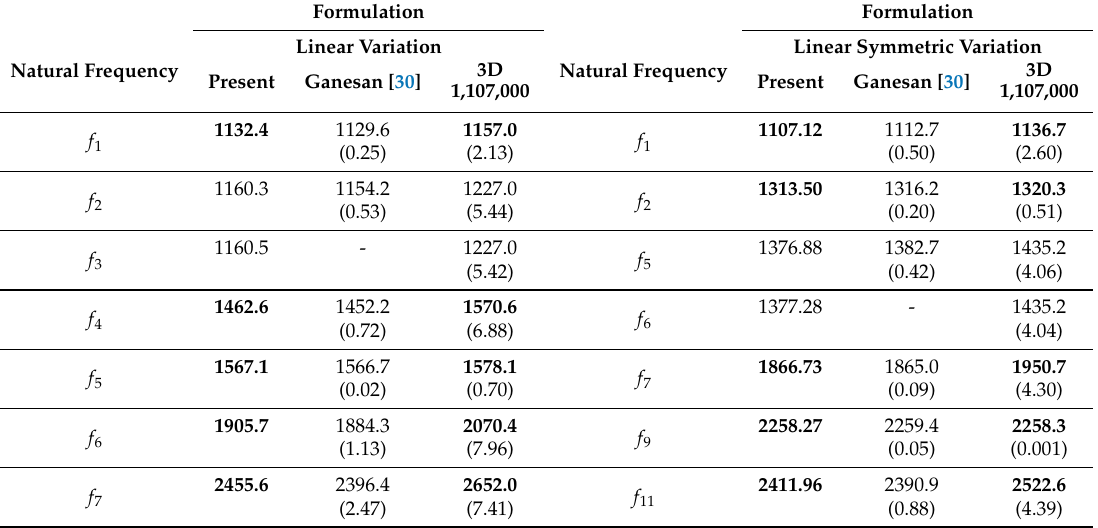
Table 15. Comparison of results for cylinders of ratio r / h m = 100, with thickness variation and CF boundary